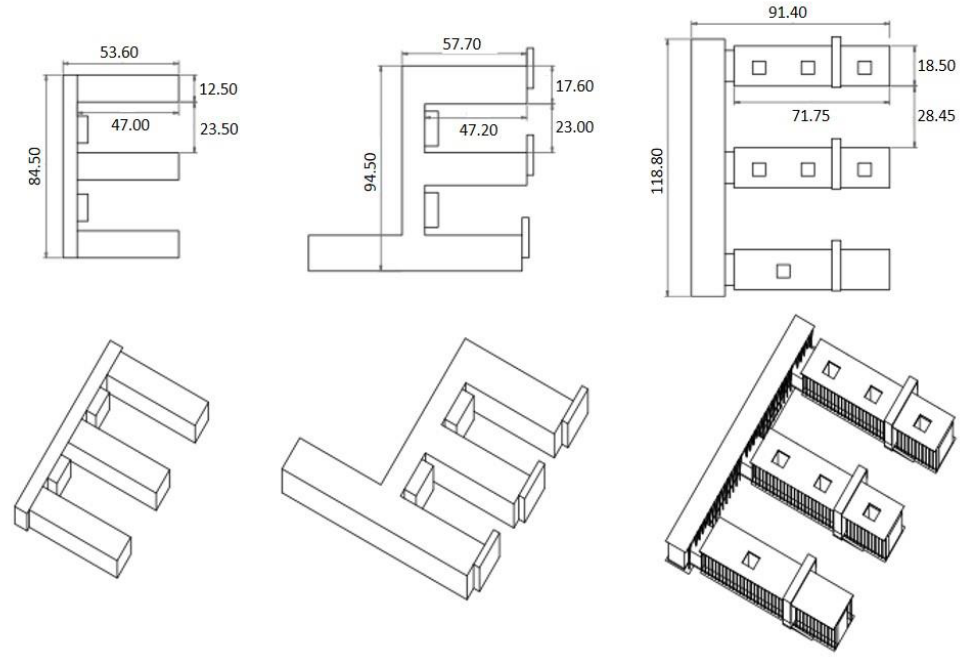
Figure 5. Di ff erent settings for the modular blocks. From left to right: Forjaz’s ‘C-shaped’ block, Figure 5. Different settings for the modular blocks. From left to right : Forjaz’s ‘C - shaped’ block, existing ‘C-shaped’ block, and proposed Pa í s’ ‘C-shaped’ block (measures in existing ‘C - shaped’ block , and proposed País’ ‘C - shaped’ block (measures in metres).